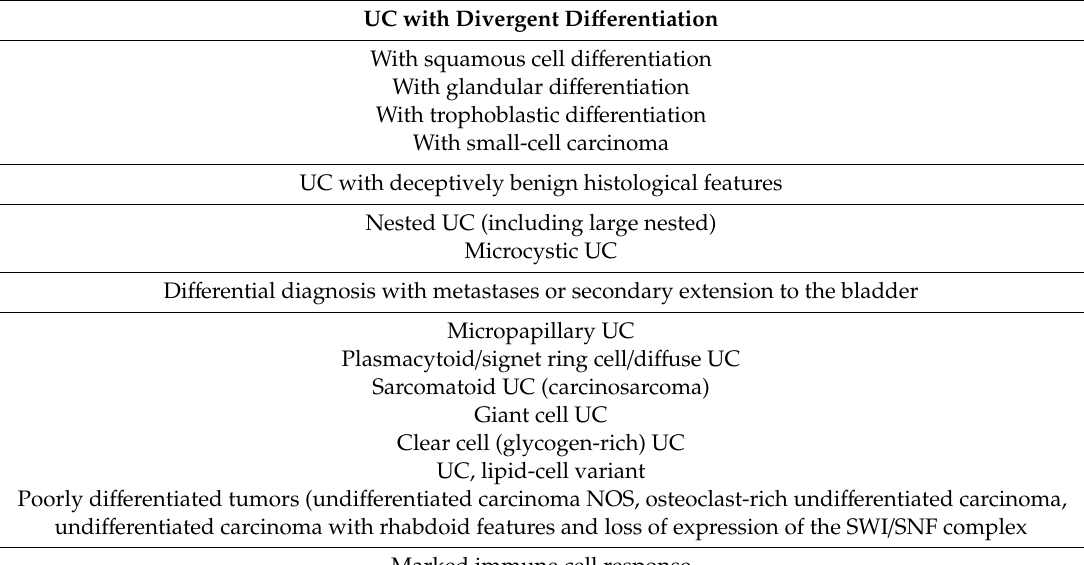
Table 1. Variant subtypes of urothelial